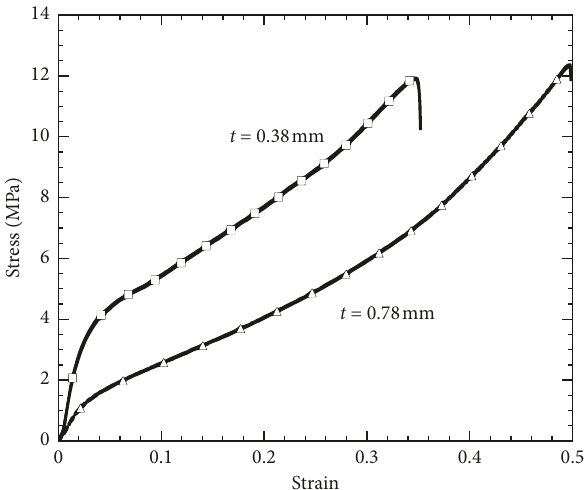
Figure 3: Effect of specimen thickness t for neat